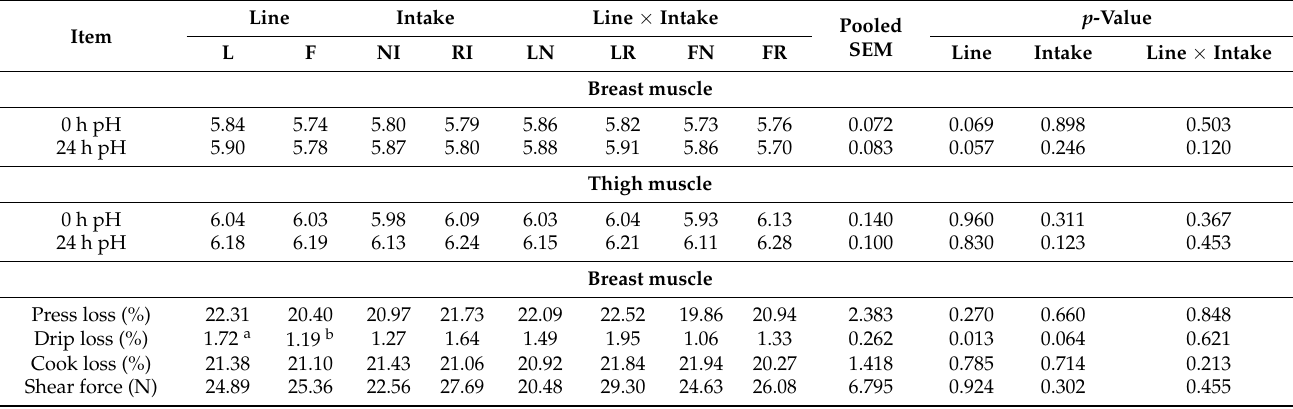
Table 4. Effect of feed intake on pH value, press loss, drip loss, cooking loss, and shear force of muscle of 56-day-old offspring in broiler hens during laying period (n = 24).